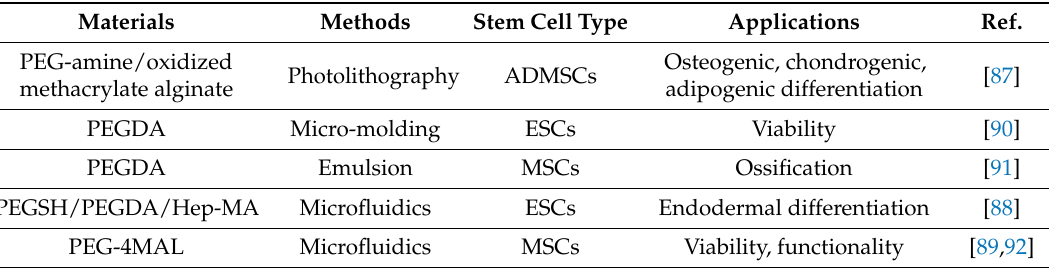
Table 5. Examples of PEG-based stem cell